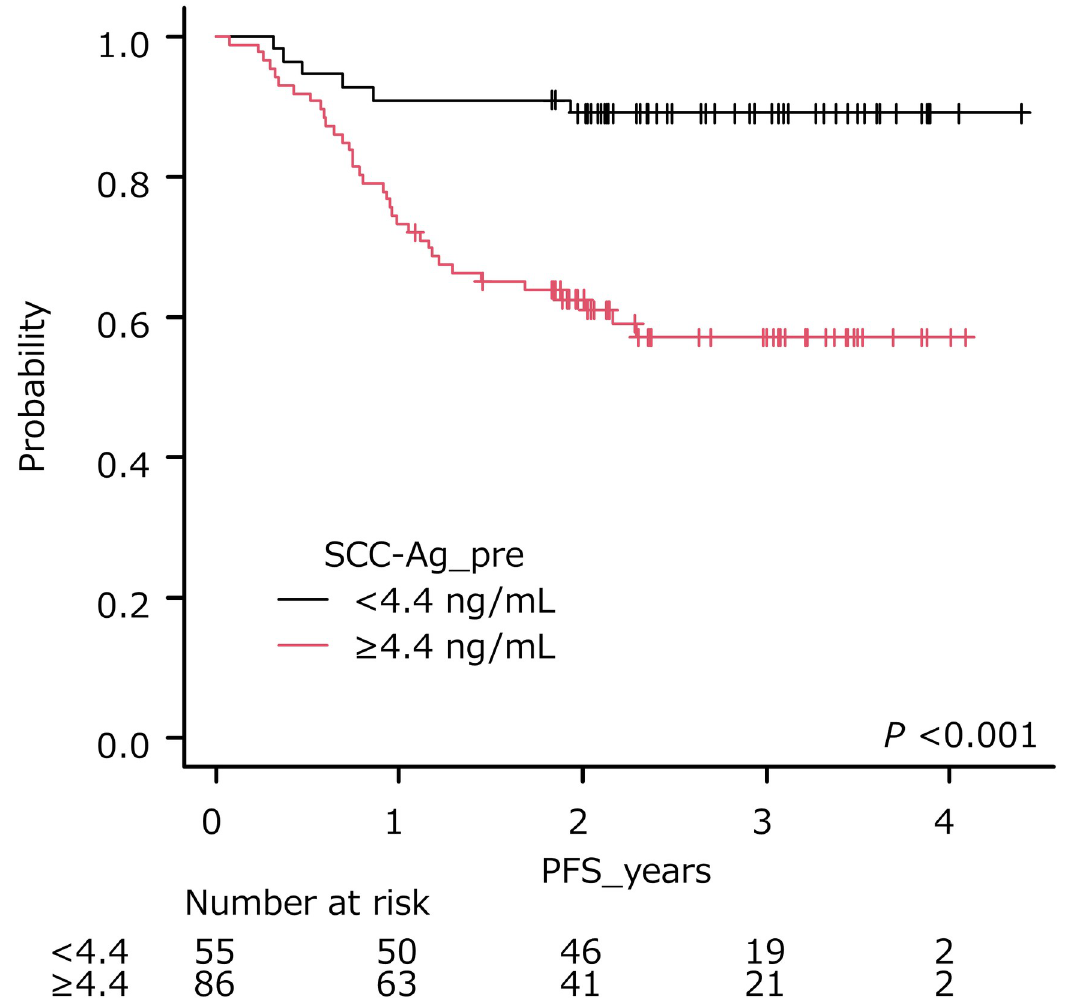
Fig 2. Progression-free survival of patients stratified by pretreatment SCC levels. Higher levels of pretreatment SCC-Ag ( � 4.4 ng/ml) were significantly associated with poorer outcome ( P < 0.001). Fig 3. Patients with pretreatment SCC-Ag levels � 4.4 ng/ml had a shorter OS than those with pretreatment SCC-Ag levels < 4.4 ng/ml ( P = 0.002, log-rank test). Multivariate analysis suggested that tumor size was an independent predictor for OS in that larger tumor size was associated with a shorter OS (HR, 2.176; 95% CI, 1.649–2.959; P < 0.001).